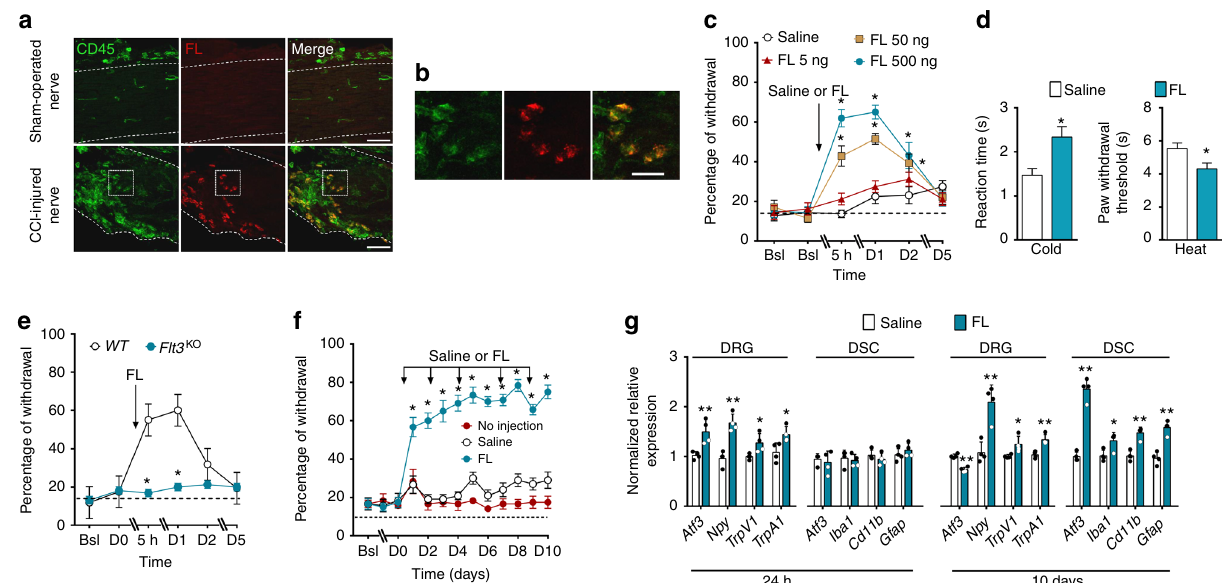
Fig. 1 In fi ltration of CCI-injured nerve by CD45/FL-positive cells and effects of intrathecal FL injections on pain sensitivity and PNP-related biomarkers. a CD45- and FL-positive cells at the site of nerve injury in the sciatic nerve, delineated by dotted lines, 10 days post-CCI. Scale bars = 50 µ m. b Enlargement of the dotted square areas in a . Bars = 20 µ m. c Mechanical pain sensitivity, measured as the percentage of withdrawal to application of von Frey fi lament, 5 h (5 h) to 5 days (D5) after a single intrathecal saline or different doses of FL injection (concentrations in ng/10 µ l). Bsl basal score before injection. d Cold and heat thermal sensitivity 24 h after intrathecal saline or FL injection (500 ng). e Mechanical sensitivity after a single intrathecal injection of FL (500 ng/10 µ l) in wild-type (WT) or Flt3 -de fi cient ( Flt3 KO ) mice. f Mechanical pain sensitivity after repeated intrathecal injections of saline or FL at the dose of (500 ng/10 µ l), measured 1 – 10 days after FL injections performed on days 1, 2, 4, 7, and 9. Control animals received no injections. g Normalized gene expressions of PNP biomarkers in the DRG and DSC measured by q-PCR 24 h after a single saline or FL injection (500 ng/10 µ l) and 10 days after repeated injections as in f . Results are means ± s.e.m. of data from 8 animals c – f or 4 animals ( g ). Two-way ANOVA and Dunnett ’ s test ( c , e , f ). Unpaired Student ’ s t -test ( d , g ).* P < 0.05; ** P < 0.01 vs. saline or WT or no